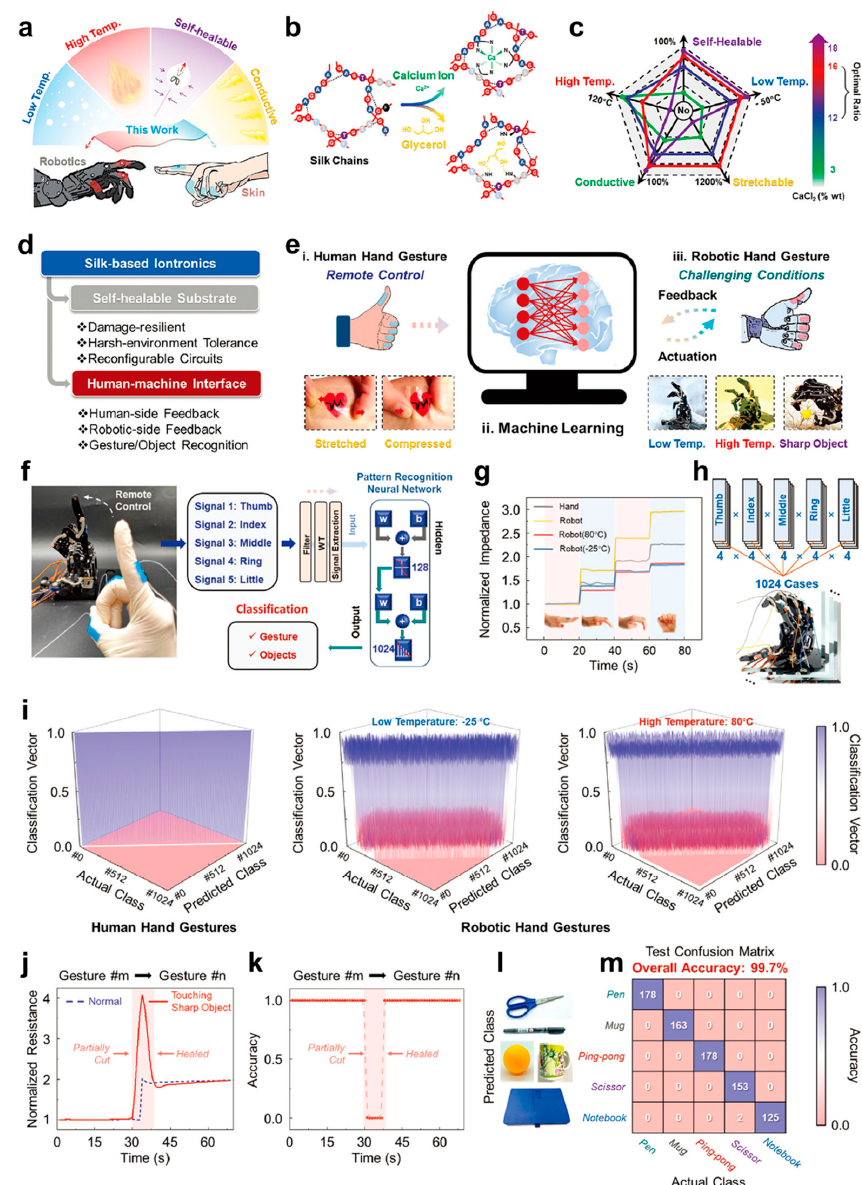
Figure 6. Performance and application of multifunctional silk protein-based iontronics. ( a ) Schematic illustration of the overall performances of iontronics. ( b ) Schematic illustration demonstrating metal coordination between Ca 2+ and silk chains and hydrogen bonds between glycerol and silk chains. ( c ) Influence of Ca 2+ content on various properties of silk-based iontronics. ( d ) The main features and application fields of silk-based iontronics. ( e ) Concept illustration of HMI system based on silk-based iontronics. ( f ) Photograph (left) of remote control for robotic hand by human hand and corresponding system (right) for classification of gesture and objects. ( g ) Normalized impedance for 4 gestures from human hand and robotic hand at high (80 °C and low ( − 25 °C) temperatures. ( h ) Signals from human and robotic hands for 1024 kinds of gestures. ( i ) Classification accuracy for human hand gestures and robotic hand gestures at − 25 °C and 80 °C. ( j ) Normalized resistance changing with different gestures at normal state and partially cut state. ( k ) Recognition accuracy variation after being partially cut and healed. ( l ) Photographs of 5 objects with different shapes. ( m ) Test confusion matrix for recognition of different objects [150].